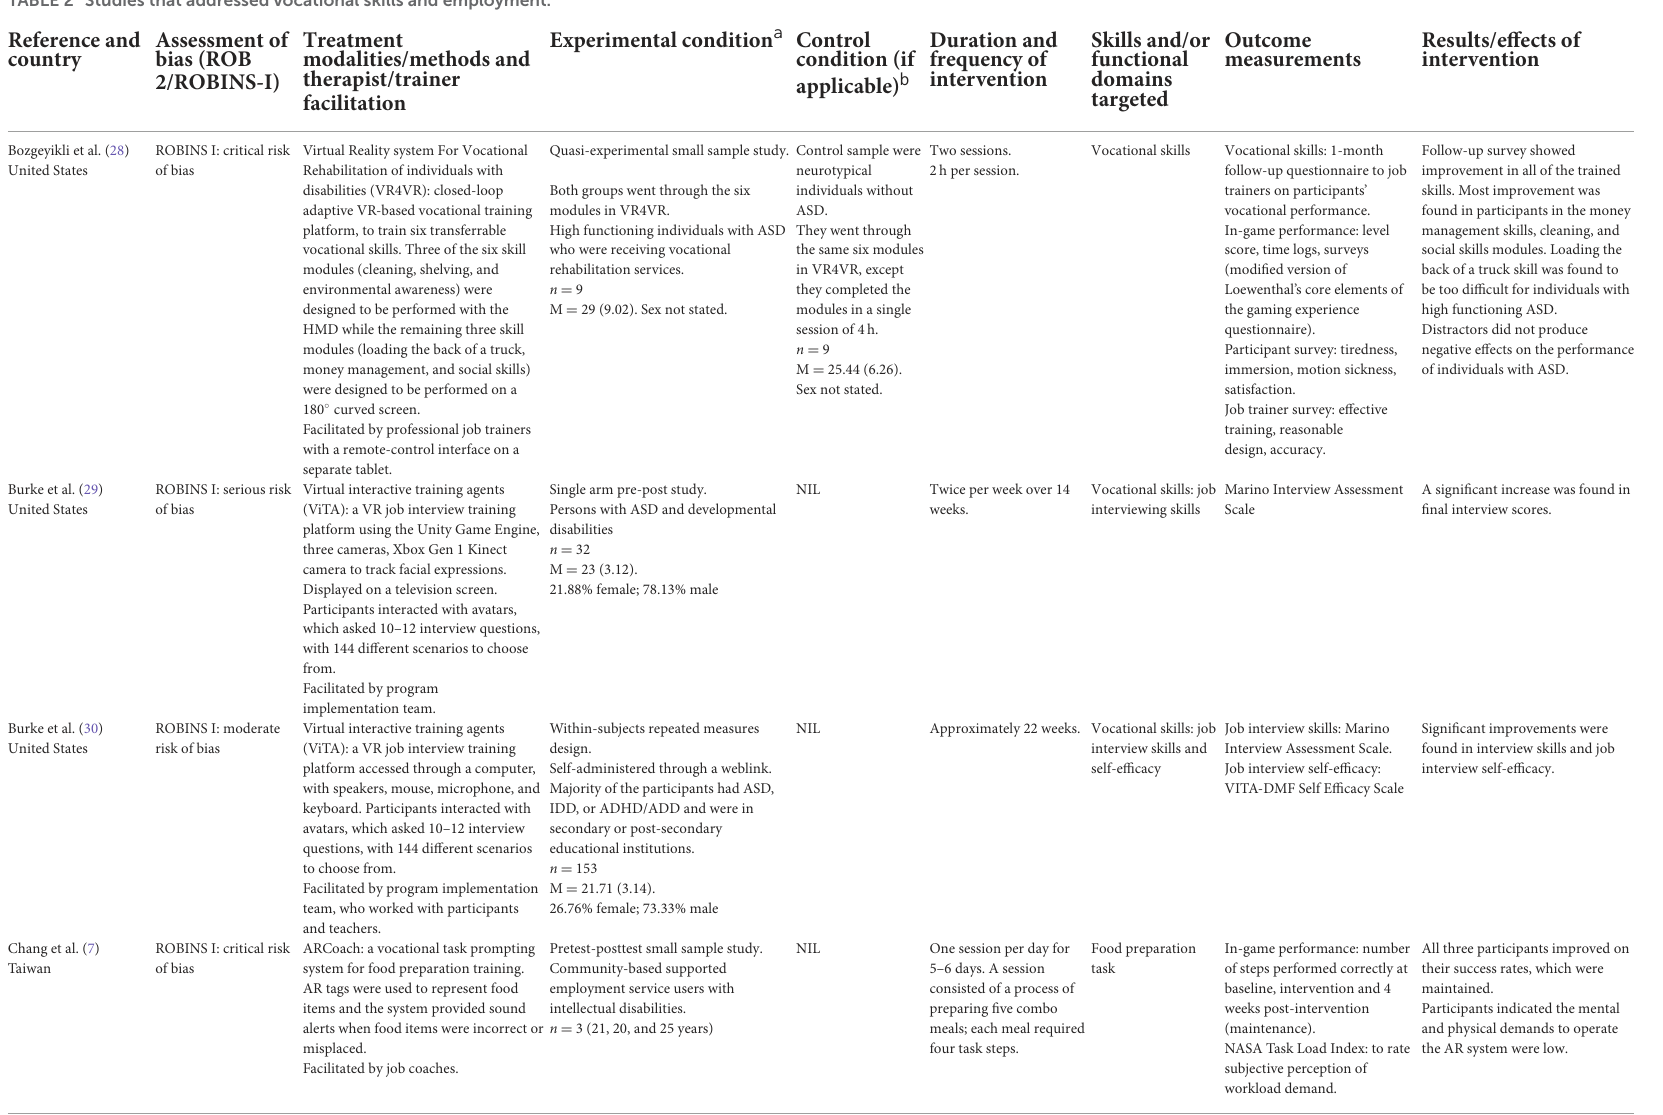
TABLE 2 Studies that addressed vocational skills and